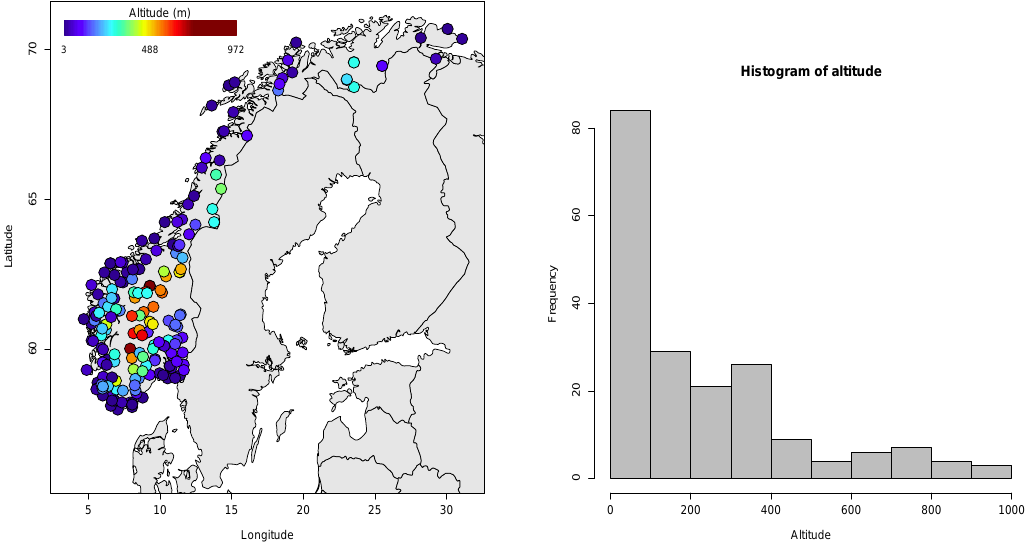
Figure 1. Left: location and altitude (ma.s.l.) of the stations. Right: histogram of altitude (ma.s.l.).